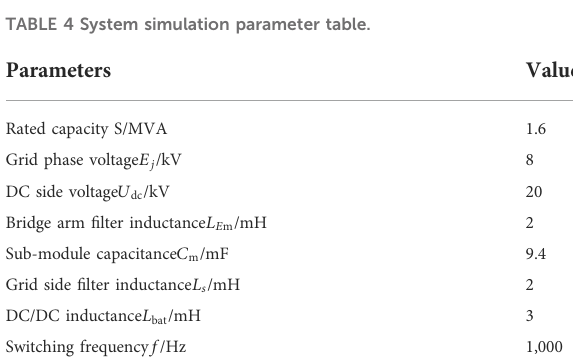
TABLE 4 System simulation parameter table.